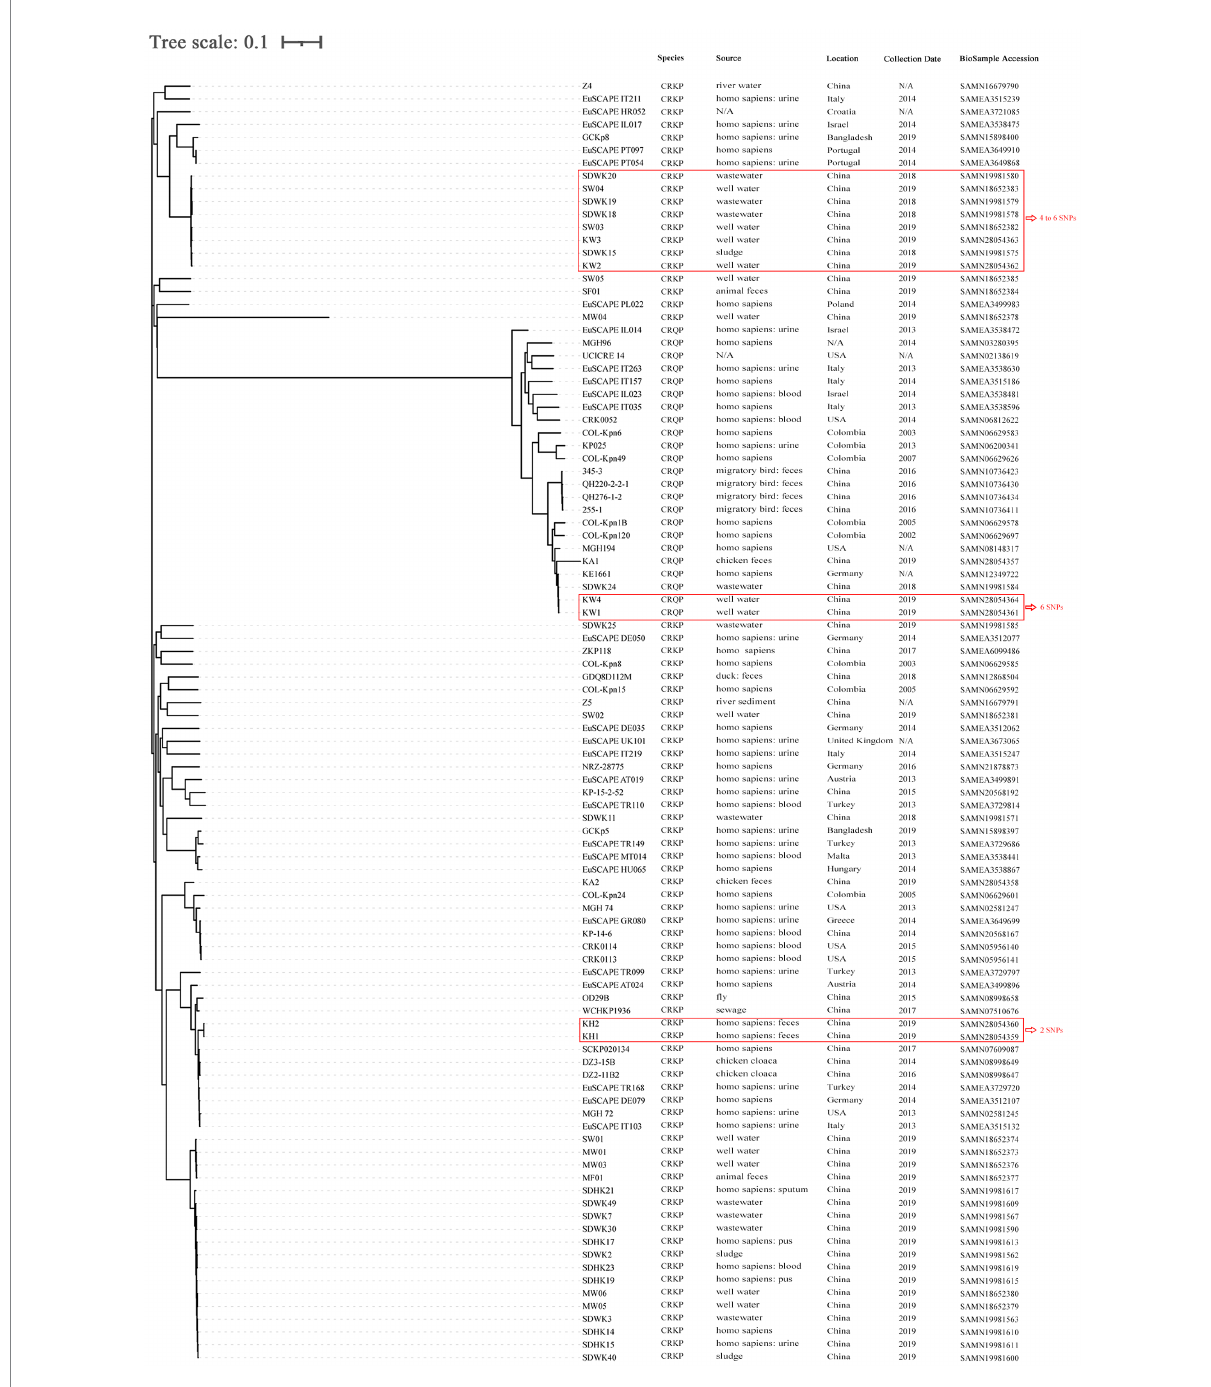
FIGURE 4 SNP-based phylogenetic tree of 8 carbapenem-resistant Klebsiella spp. isolated from animal breeding area in this study, and another 72 carbapenem-resistant Klebsiella pneumoniae (CRKP) and 20 carbapenem-resistant Klebsiella quasipneumoniae (CRKQ) in NCBI database. The sample identifier, location, collection date and source were indicated for each isolate. The number of SNPs denoted in red outside the rectangles indicate the number of SNPs differing between the isolates. K. pneumoniae MGH 78578 (GenBank: NC_009648.1) genome sequence was used as reference for construction of the phylogenetic trees based on SNP differences. N/A, not